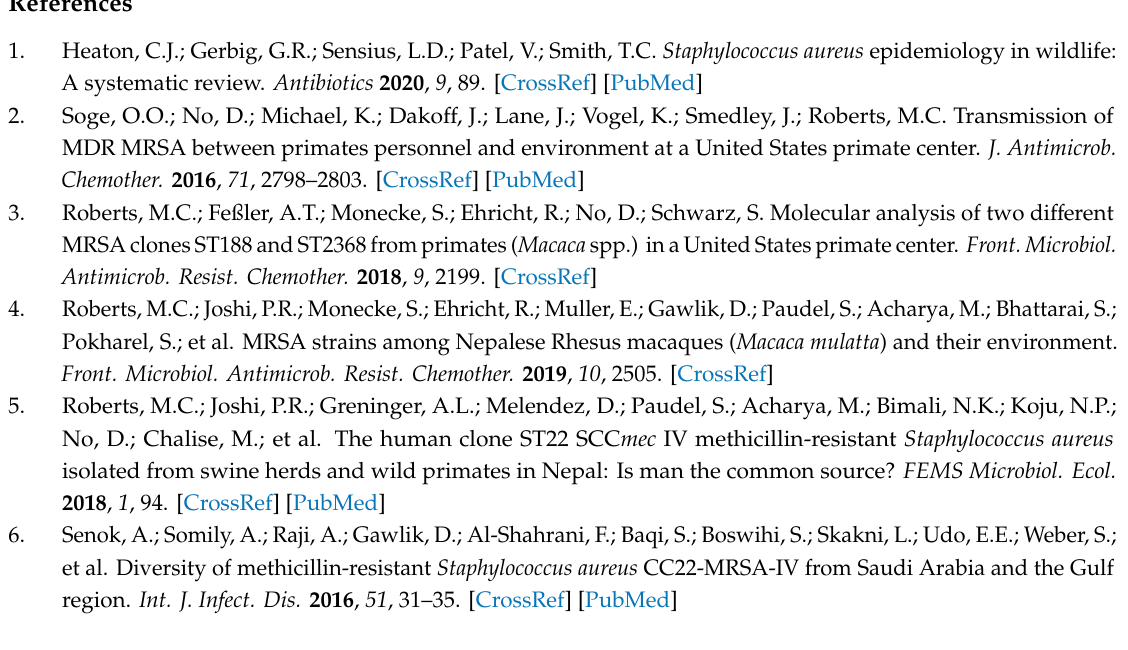
Table S1: MLST Sequences. Table S2 MICs of the